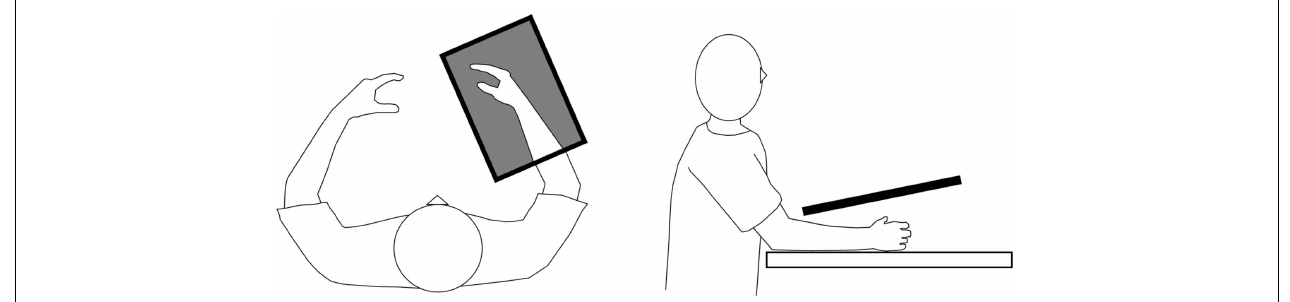
FIGURE 1 | Schematic diagram of the kinesthetic illusion induced by visual stimulation intervention.